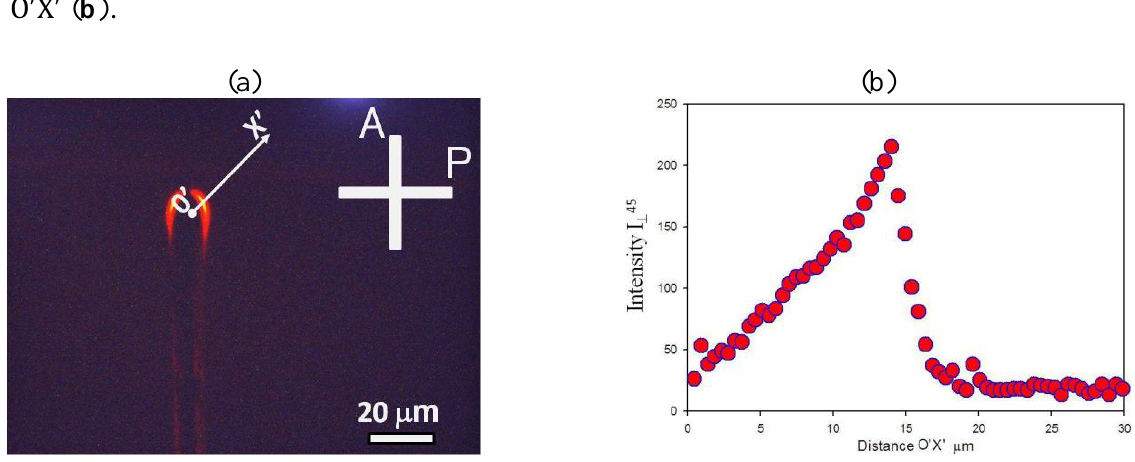
Figure 10. Texture of the flat cell with the toluene dispersion of Au NRs under an applied voltage U = 200 V , f = 100 kHz, viewed in monochromatic light at 656 nm between two rms crossed polarizers A and P (a) ; transmitted light intensity 𝐼 ⊥45 measured along the direction O′X′ ( b